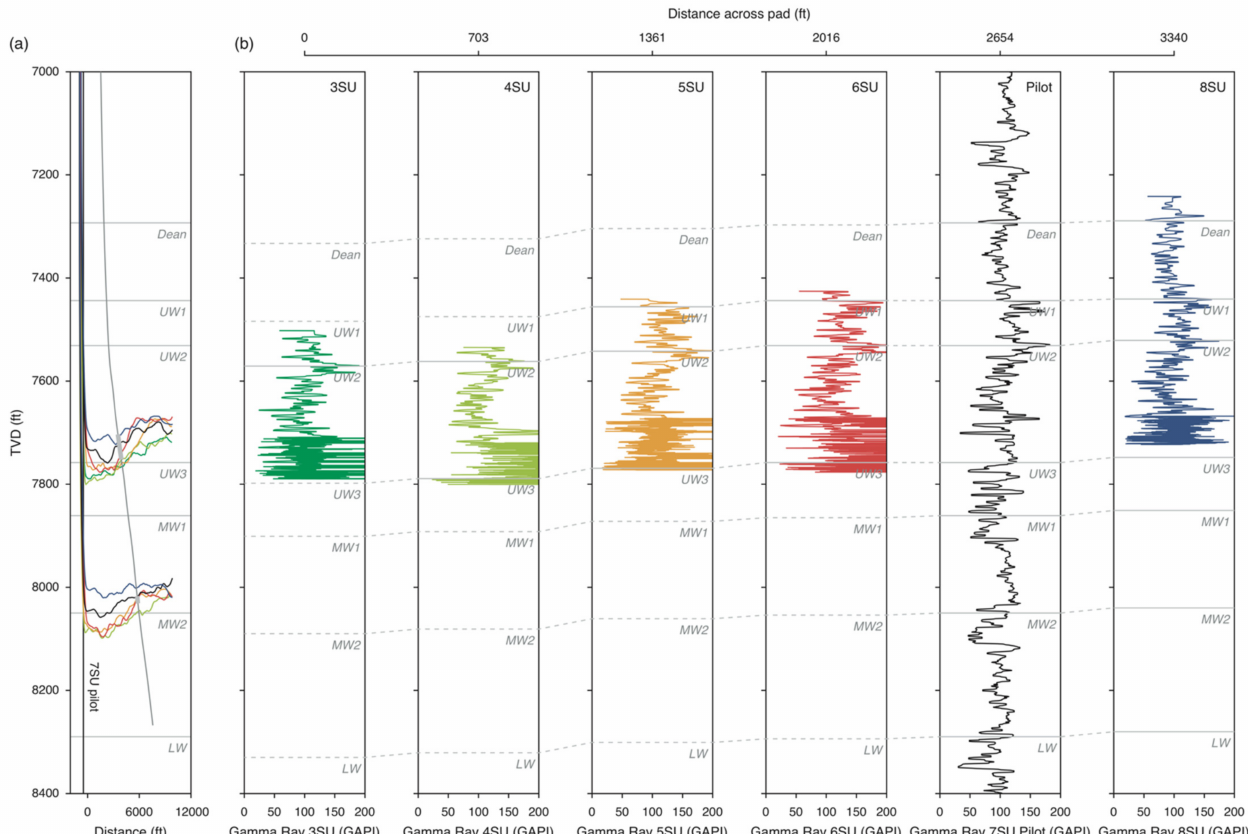
Figure A2. Stratigraphic shift for the Upper Wolfcamp (-SU) wells. ( a ) Wells in cross section, not shifted by stratigraphic depth with respect to the 7SU pilot well. ( b ) Gamma ray logs from horizontal wells 3SU–8SU and the 7SU pilot well. Solid lines indicate the location of formation tops correlated with the 7SU pilot well. Dashed lines indicate the interpreted depth of formation tops based on the stratigraphic difference with respect to the 7SU pilot